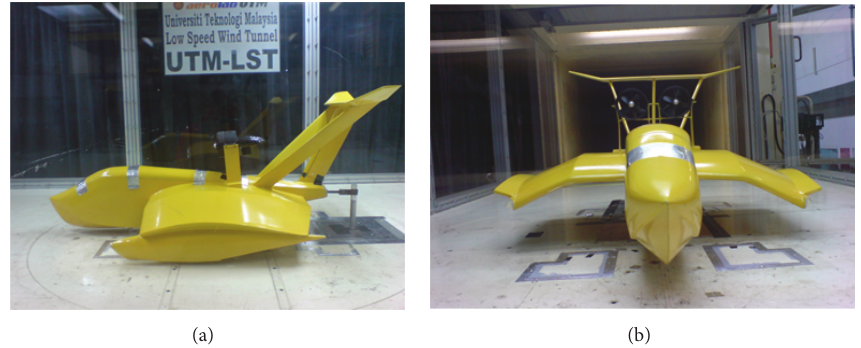
Figure 4: Wind tunnel test for WIG craft model: (a) model with endplates and (b) model without endplates.